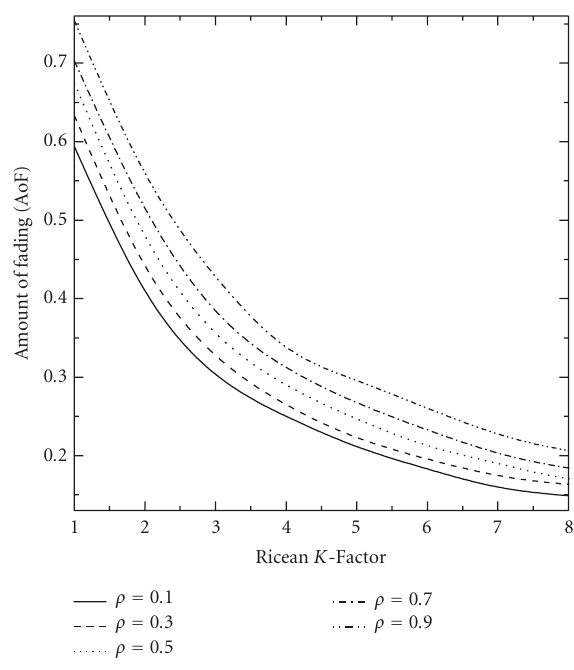
Figure 2: Amount of fading (AoF) versus the Ricean K -factor for several values of the correlation coe ffi cient ρ